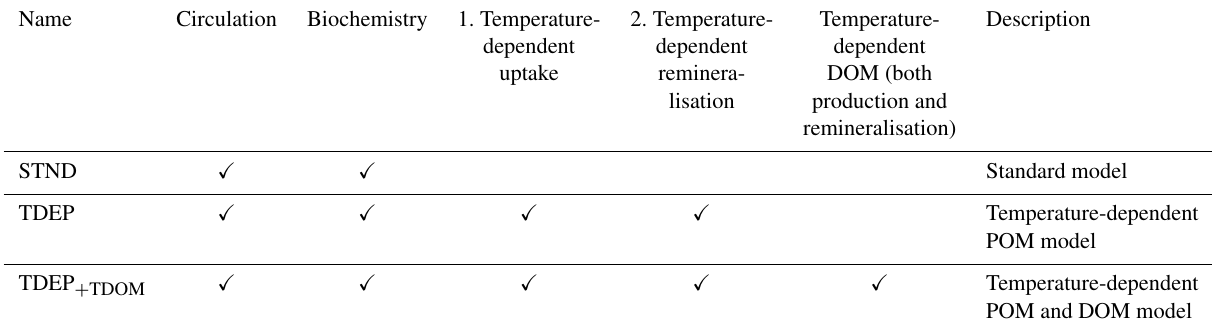
Table 2. Model settings and processes included in each set-up. Column numbering corresponds to numbering in Fig. 1.